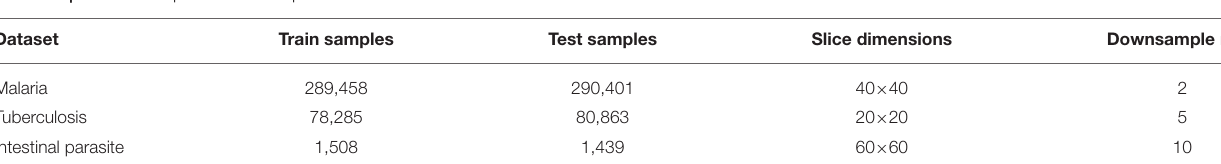
TABLE 1 | Dataset samples used for experiments.